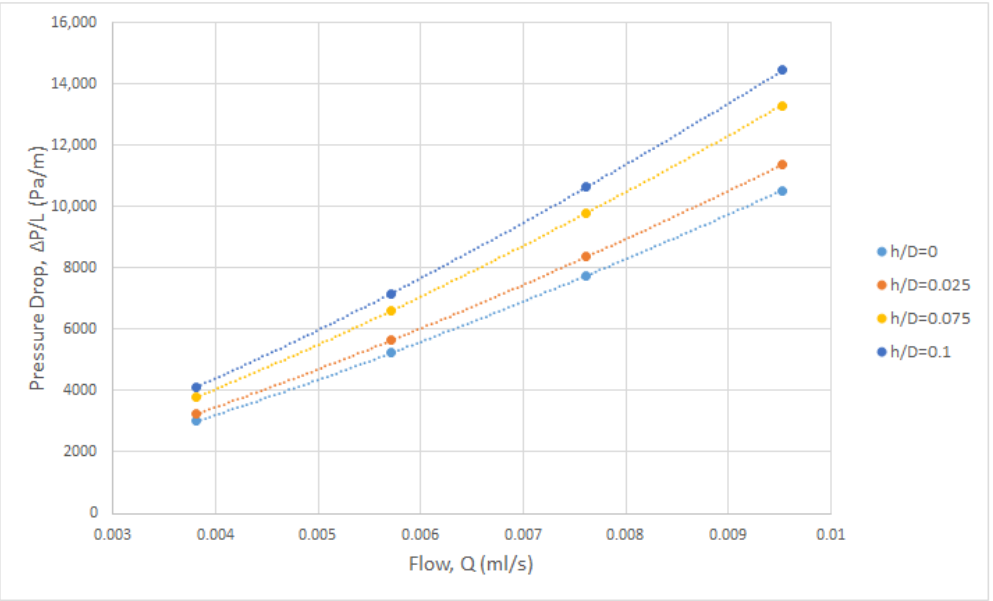
Figure 7. Computational results on the effect of gap reduction h on pressure drop ΔP/ΔL (Pa/m) in the retentate channel.